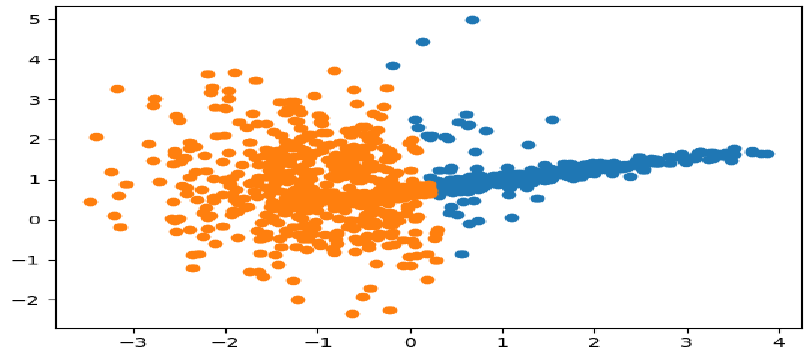
Figure 1. Simulated results for the two clusters showing two states of the sensor with 2 features.